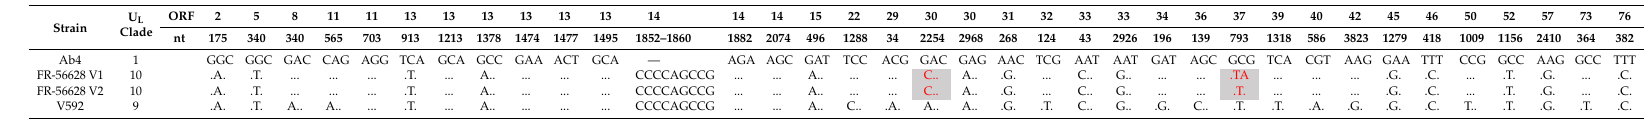
Table 3. MLST codon alignment between reference strains Ab4 and V592, and strain FR-56628 variants V1 and V2, based on MLST. FR-56628 nucleotides in ORF30 position 2254 and ORF37 are highlighted in